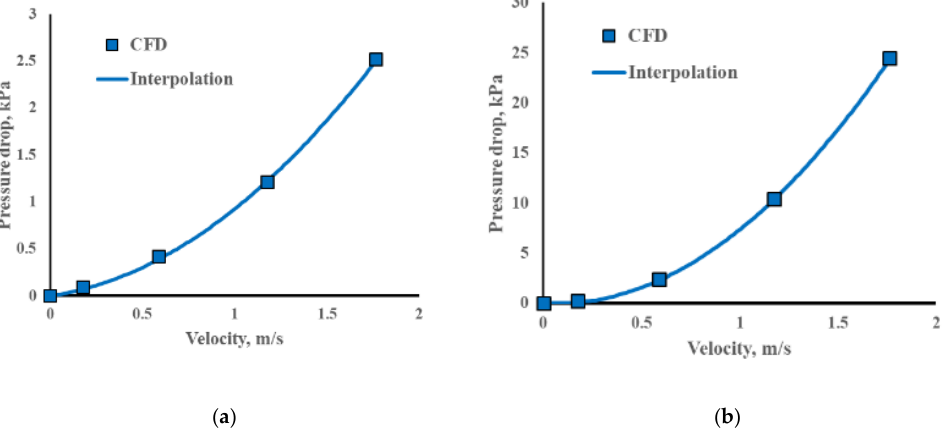
Figure 11. Pressure drop depending on the volumetric flow rate: channel with a pore diameter of Ø 85 ( a ) and Ø 63 ( b ) microns. To conduct numerical simulation, a network model was constructed (Figure 12) con- sisting of 9628 nodes and 18,954 branches. The distribution structure of straight and pinched channels was similar to that in the original chip (Figure 13). Figure 12. Network model of the Dolomite microchip: 3200284.